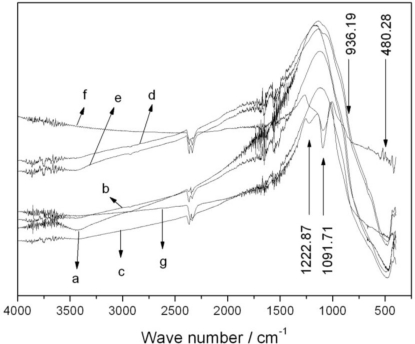
FTIR spectra of photocatalysts: (a) TiO2; (b) 0.1%Fe3O4/SiO2/TiO2; (c) 0.25%Fe3O4/SiO2/TiO2; (d) 0.5%Fe3O4/SiO2/TiO2; (e) 1%Fe3O4/SiO2/TiO2; (f) 5%Fe3O4/SiO2/TiO2; (g) 10%Fe3O4/SiO2/TiO2.